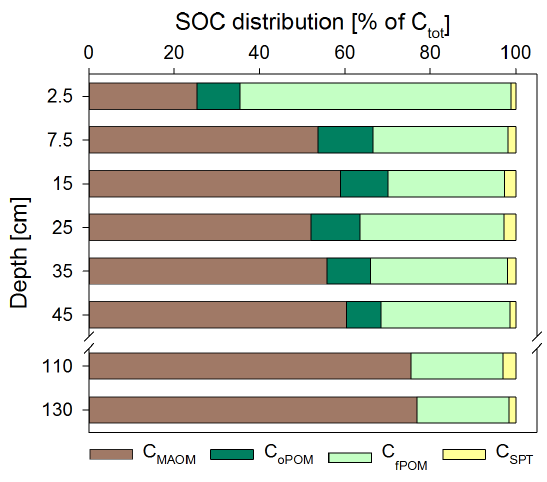
Figure 2. Soil OC (SOC) distribution in the Dystric Cambisol at the Grinderwald site as a function of soil depth: C in mineral-associated OM (C MAOM ), occluded particulate OM (C oPOM ), and free partic- ulate OM (C fPOM ); C mobilized by sodium polytungstate during density fractionation (C SPT ). All data are given as mean of both samplings ( n = 12; standard deviation varied for C MAOM between 7% and 19%, for C oPOM between 2% and 5%, for C fPOM between 7% and 19%, and for C SPT between 0.3% and 5%). Note that the C MAOM fraction was corrected for the C loss during washing (see Sect.